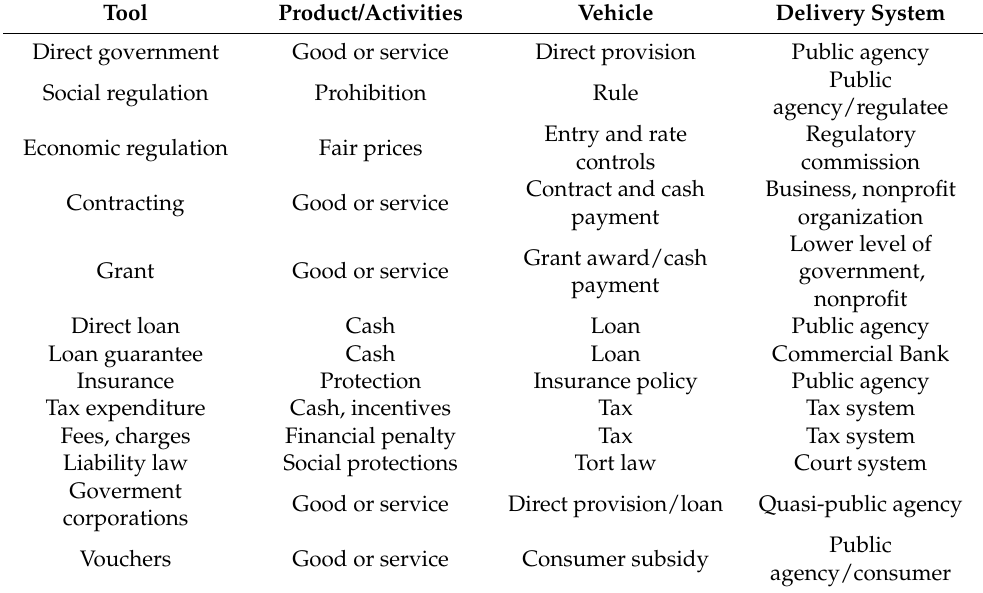
Table 1. Classification of common tools of public policy action according to Salamon (2001) [39]. Tool